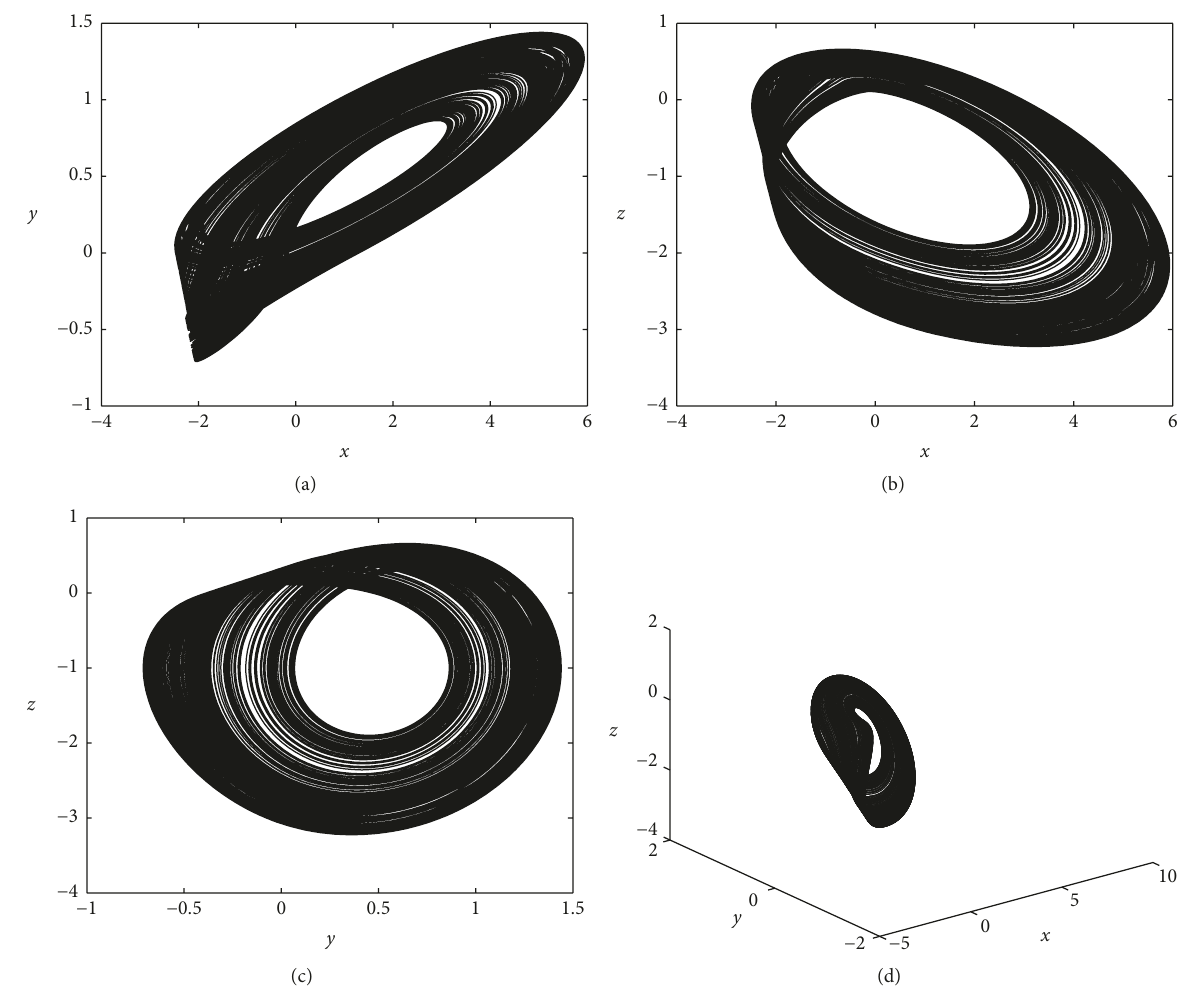
Figure 4: Phase portrait observed in (a) 𝑥 - 𝑦 plane, (b) 𝑥 - 𝑧 plane, (c) 𝑦 - 𝑧 plane, and (d) 𝑥 - 𝑦 - 𝑧 space for 𝑎 = 6.8 , 𝑏 = 4 , and 𝑐 = 1 and initial conditions (𝑥(0),𝑦(0),𝑧(0)) = (0,0,0) .